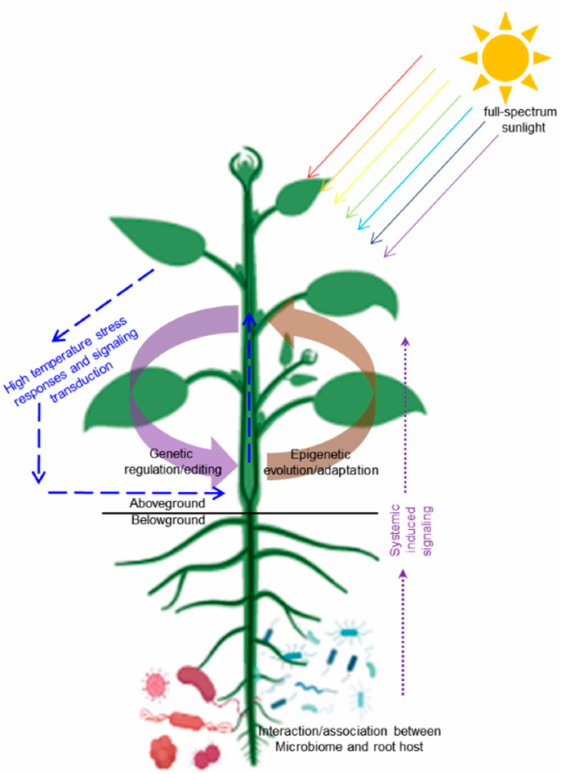
Figure 1. Schematic model showing that genetic and epigenetic dependent regulations/adaptations in molding the plasticity of vegetable plants responding to high temperature stress. The figure is created with bioRender.com with a few